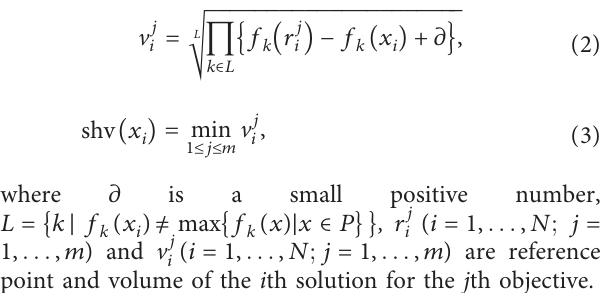
Figure 1: v j i calculation: the shadow is volume between reference point r j i on objective j